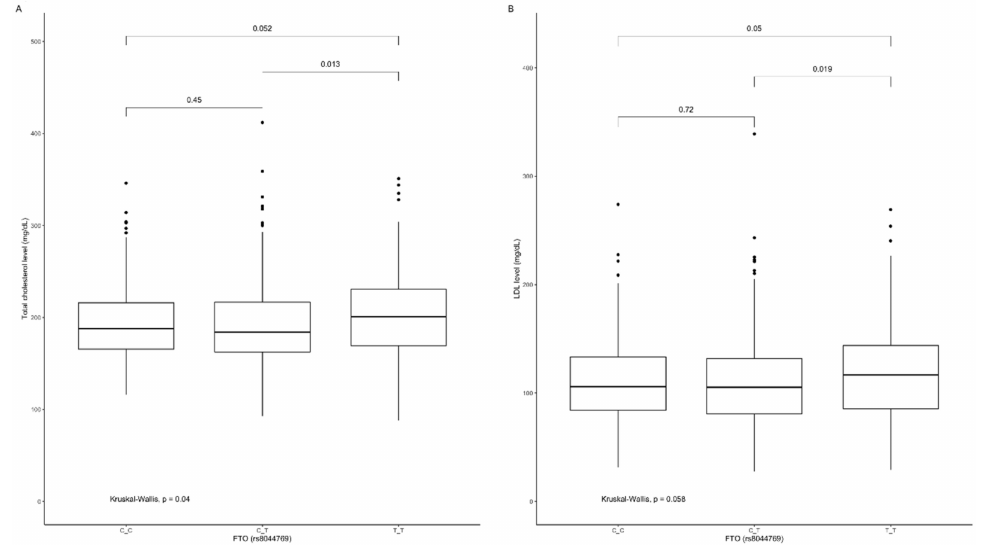
Figure 9. Association of FTO genotypes rs8044769 with ( A ) total cholesterol level (mg / dL) and ( B ) LDL level (mg /